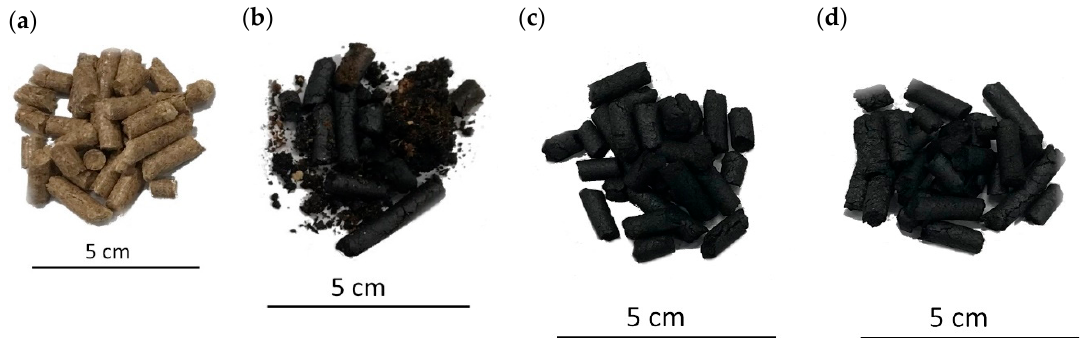
Figure 11. Samples of pellets before and after torrefaction ( a ) raw pellet, ( b ) ap, ( c ) hpd, ( d ) hps.